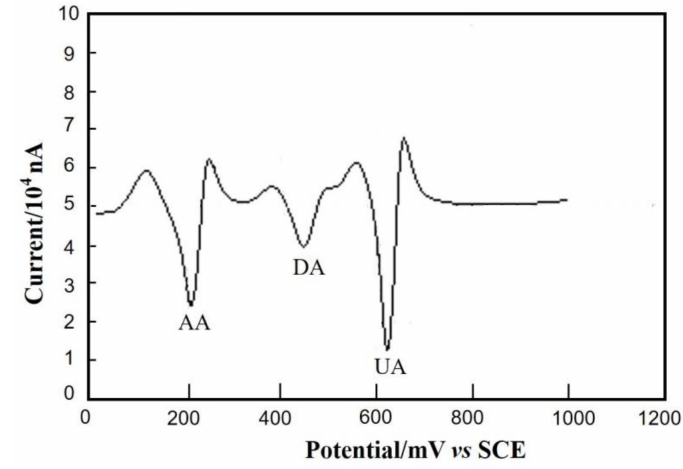
Figure 10. The Second-order derivative linear sweep voltammetry (SDLSV) of DA obtained on the NH 2 –Fe 3 O 4 /RGO/GCE in the mixture of ascorbic acid (AA) (1 × 10 − 5 mol/L), DA (2 × 10 − 5 mol/L) and uric acid (UA) (1 × 10 − 5 mol/L). Scan potential range: 0–1.0 V; scan rate: 100 mV/s; supporting electrolytes: 0.1 mol/L